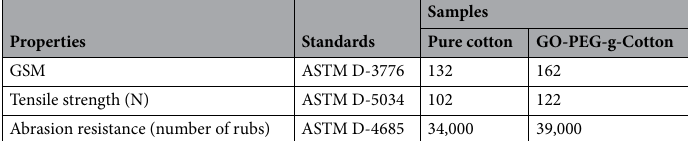
Table 2. Effect of modification on cotton intrinsic